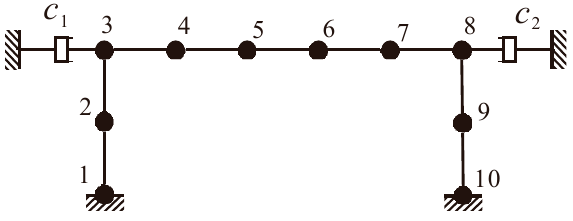
Figure 2. A frame with concentrated damper.